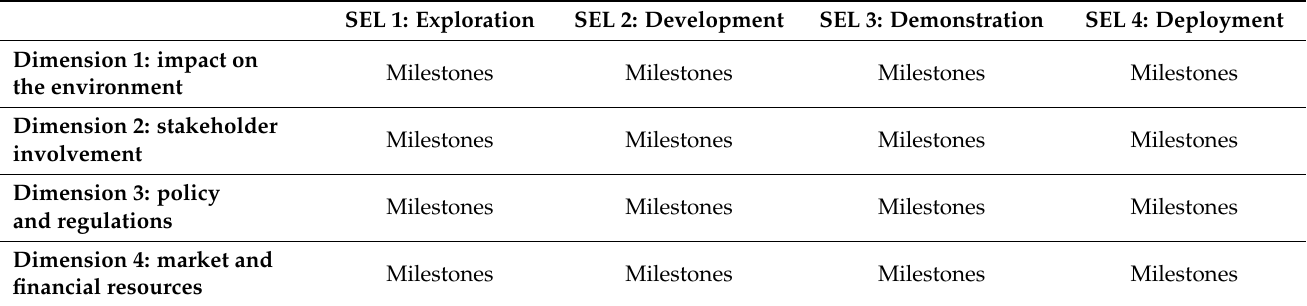
Table 8. The SEL assessment